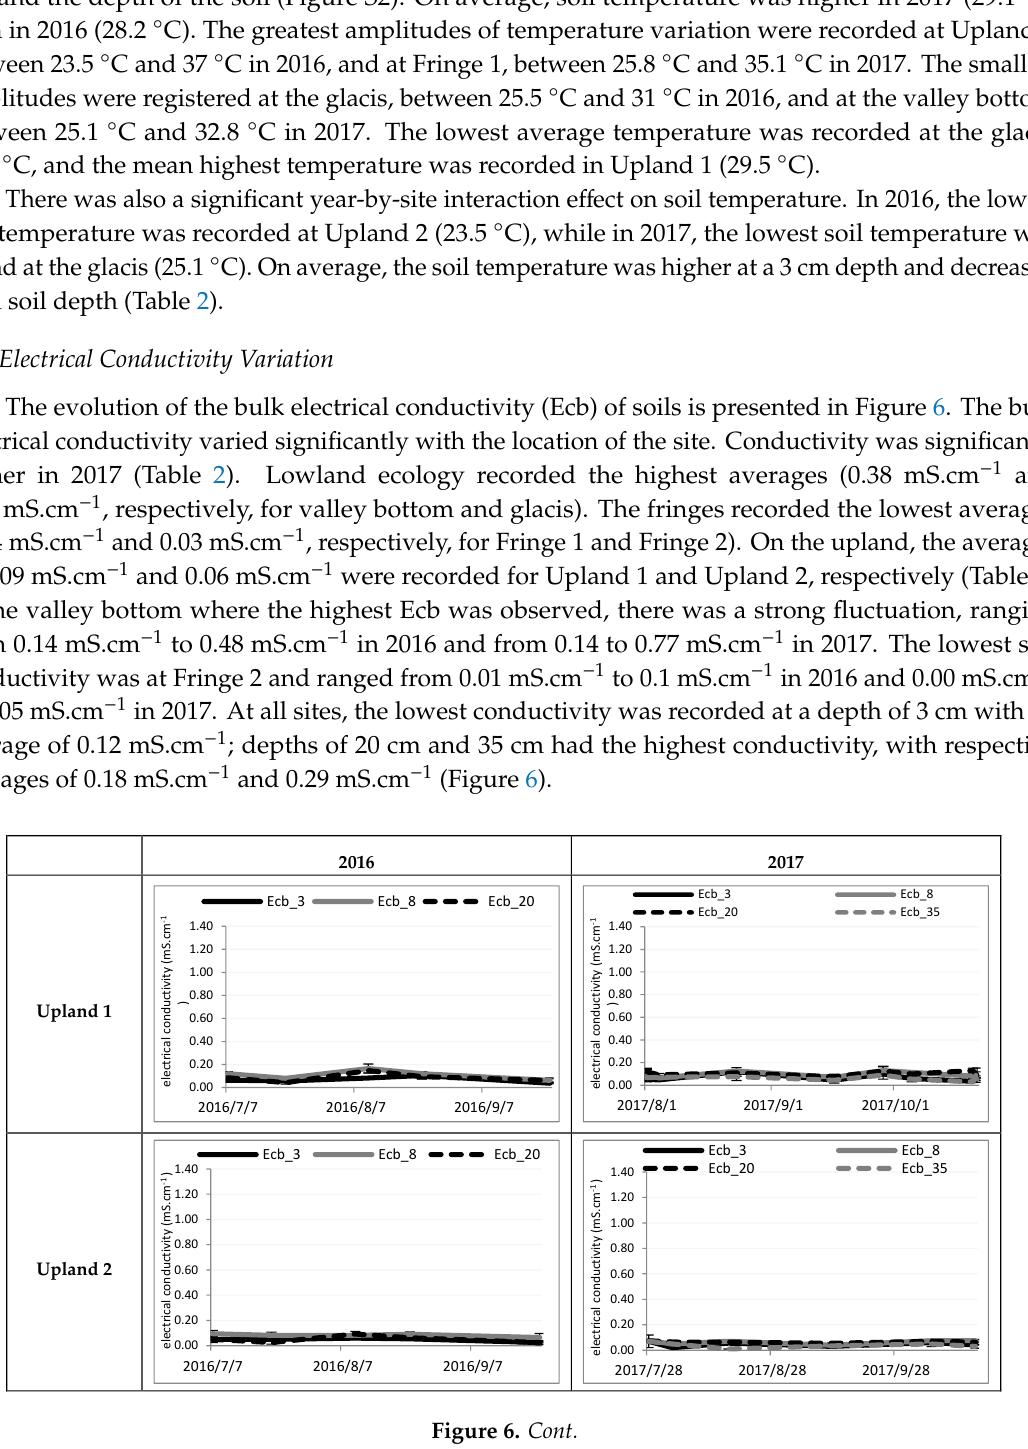
Figure 5. Soil moisture at different soil depths during the 2016 and 2017 growing seasons. Error bars indicate the standard errors of the mean.